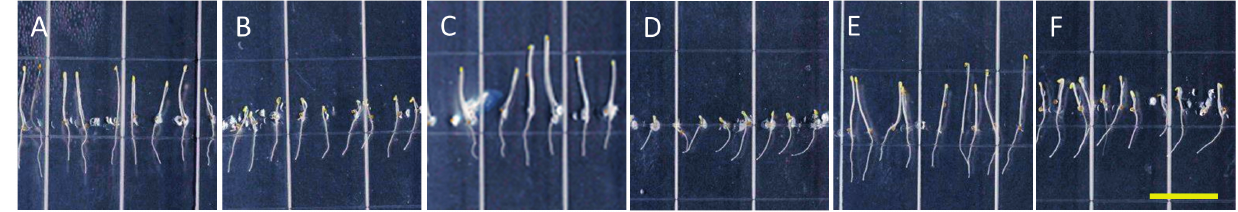
Figure A2. Etiolation response of four-day-old nhx1nhx2nhx3nhx4 . WT ( A , C , E ) and nhx1nhx2nhx3nhx4 ( B , D , F ) grown on 1 mM K + , 1 mM Na + ( A , B ), 30 mM K + ( C , D ) or 30 mM Na + ( E , F ). Root growth of nhx1nhx2nhx3nhx4 does not differ between treatments, but hypocotyls are shorter on 30 mM K + ( D ) than 1 mM K + , 1 mM Na + ( B ) or 30 mM Na + ( F ). Growth of both roots and hypocotyls in WT is unaffected across treatments. The yellow bar is 1